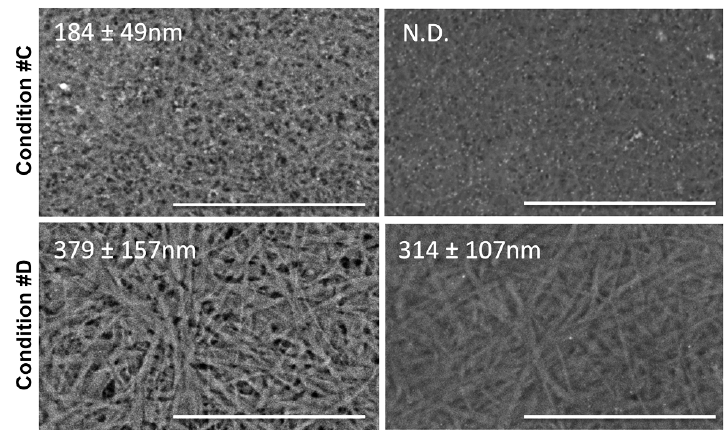
Figure 3. Scanning electron microscopy of collagen gels . Collagen gel organization, in the absence/presence of foetal bovin serum (FBS), is investigated by scanning electron microscopy (SEM). Images correspond to the four experimental conditions as in Figure 1. Values represent the mean diameter of collagen fibrils ± SD. N.D. not determined. Bar: 10 μ m.